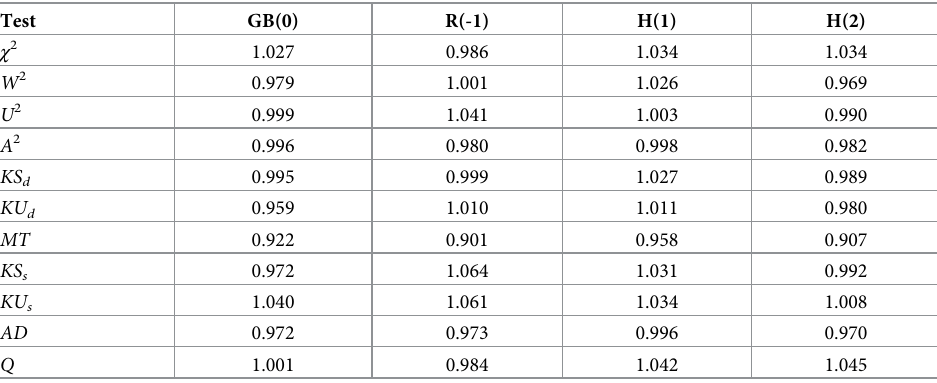
Table 2. Rejection rates ( × 100) when the Benford null (3) is